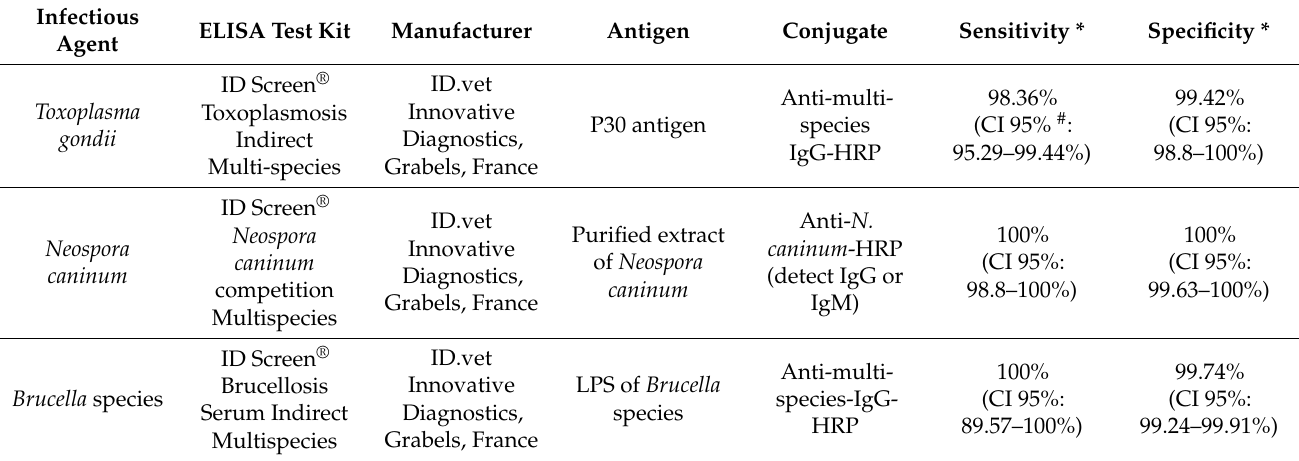
Table 2. Commercially available ELISA test kits used for detecting antibodies to T. gondii , N. caninum , and Brucella